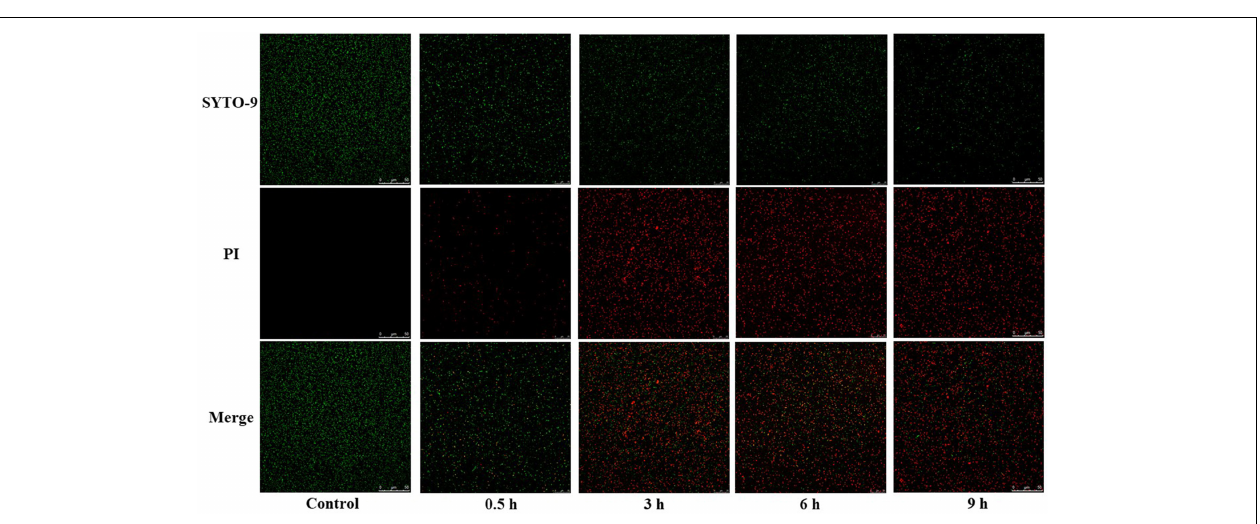
FIGURE 5 | LSCM images of Y. enterocolitica after CA